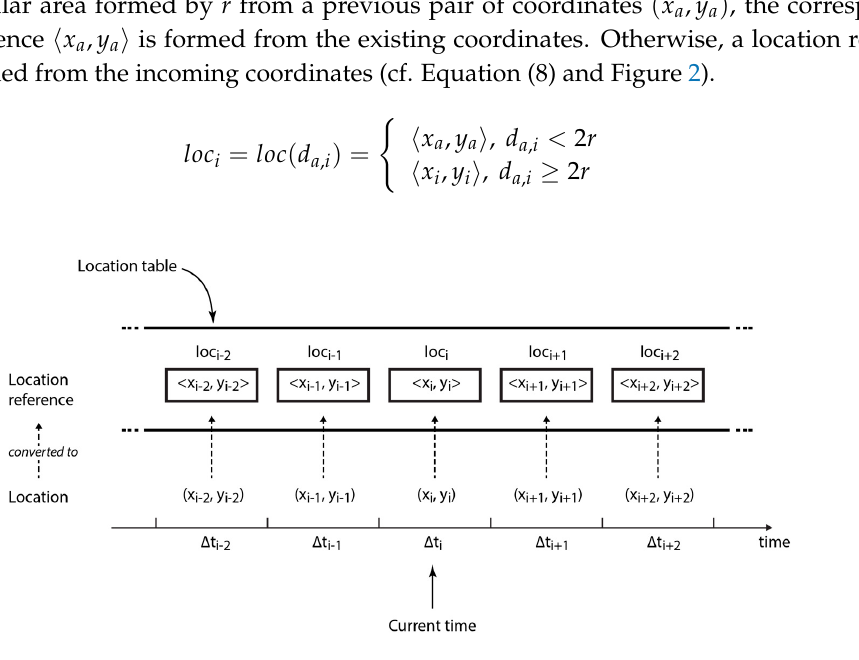
Figure 2. Structure of the location table.